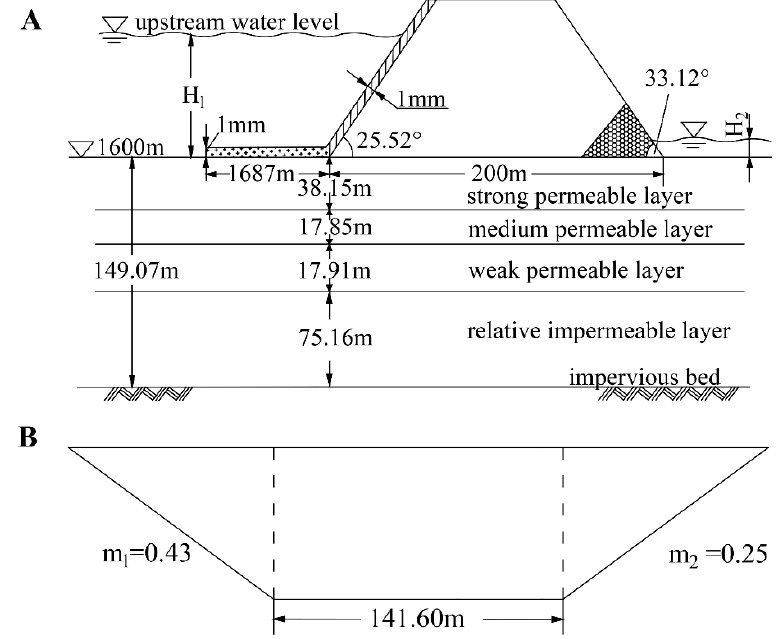
Figure 10. Simplified calculation diagrams: ( A ) a typical cross section of the Shangmo dam; ( B ) a front view of the simplified slope wall.